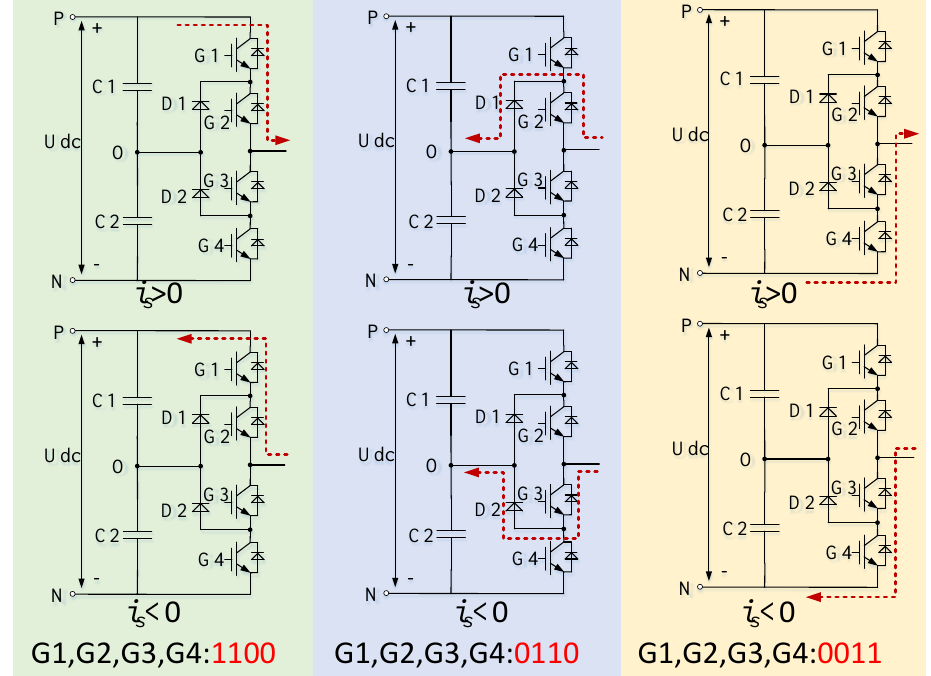
Figure 4. The current path in the different switching modes of the TL-NPC.